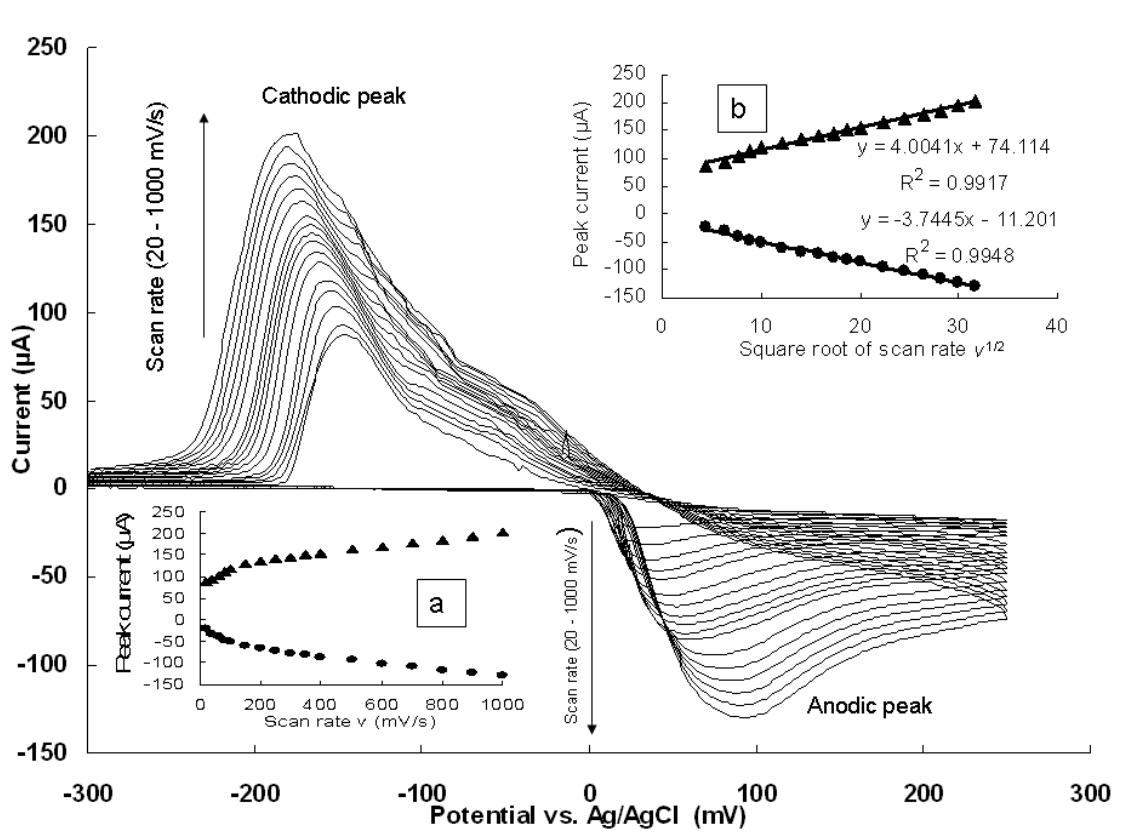
Figure 2. Cyclic voltammograms of silver electrode were obtained for 300 µM KBr in KNO Scan rates from inner to outer are: 20, 40, 60, 80, 100, 150, 200, 250, 300, 350, 400, 500, 600, 700, 800, 900, 1000 mV/s. Inset a) Relationship of peak current and scan rate ( v ) and inset b ) Relationship of peak current and square root of scan rate ( v 1/2